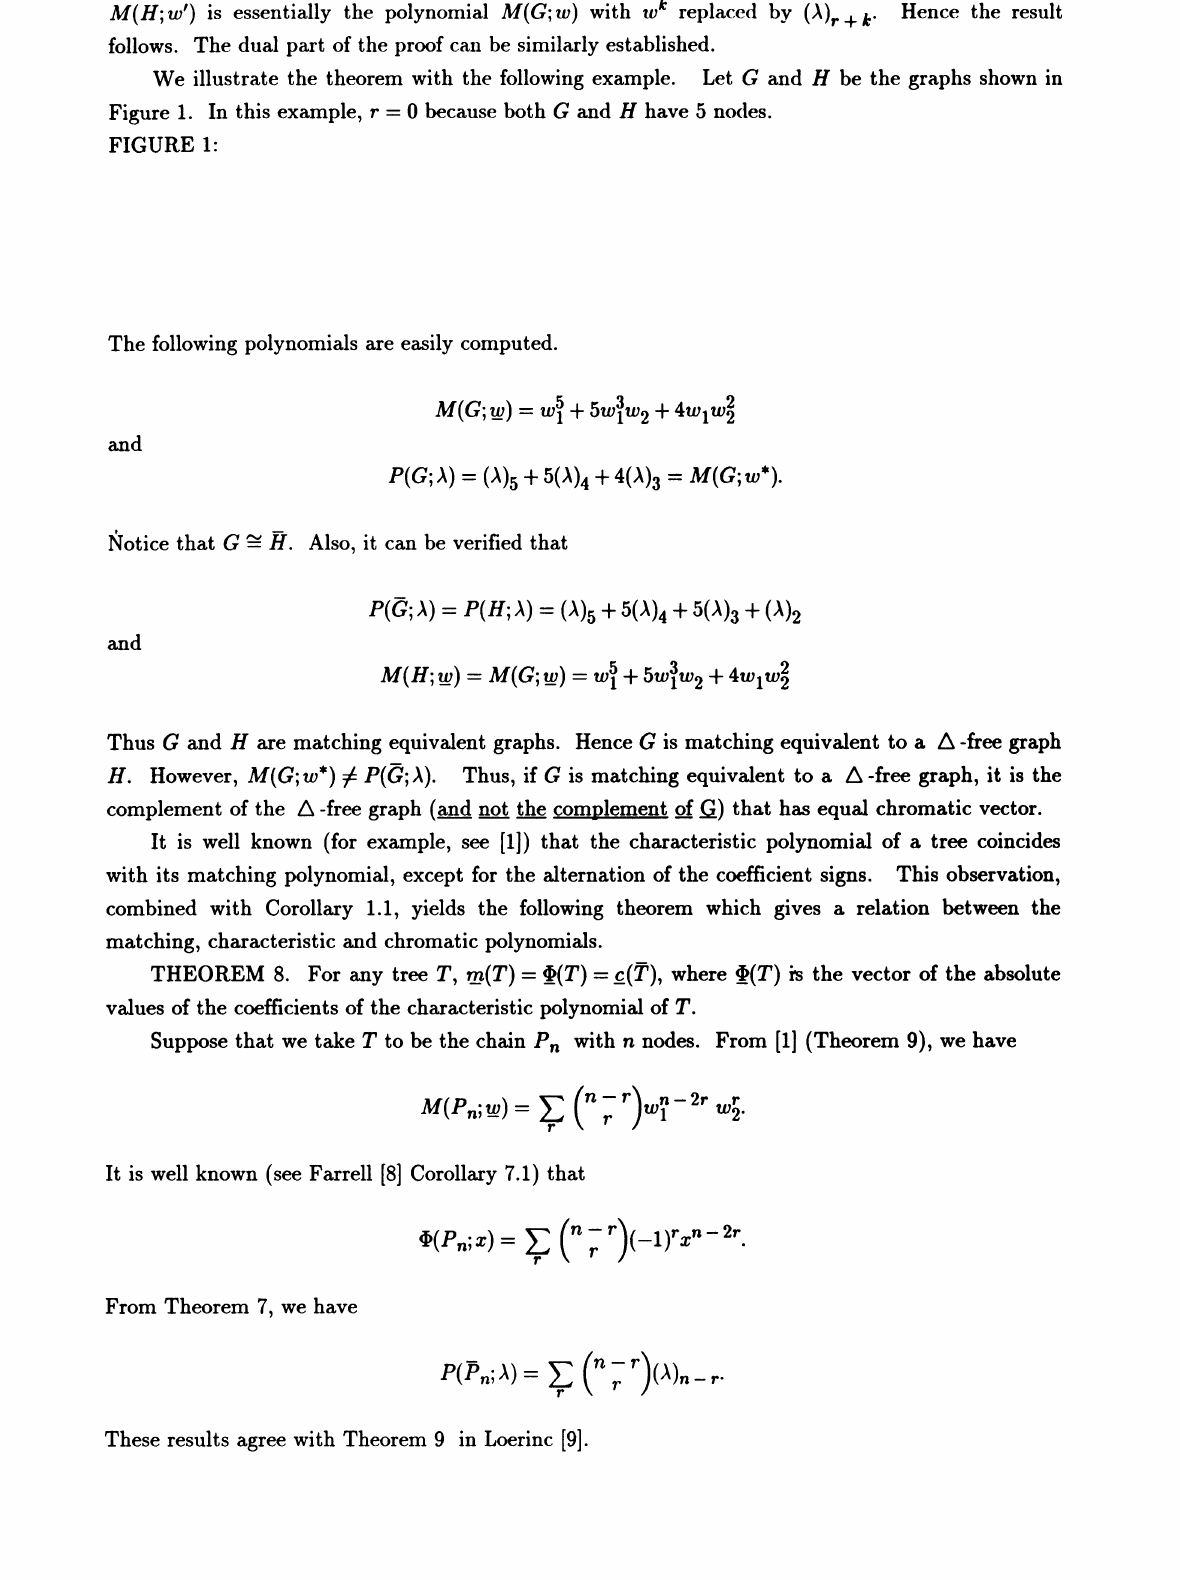
Figure 1. In this example, r 0 because both G and H have 5